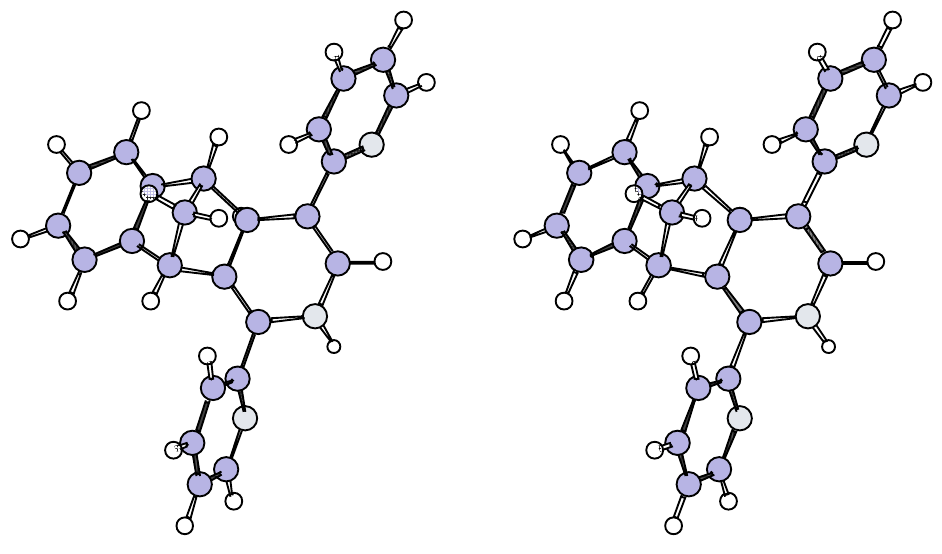
Figure 2. Stereoview of preferred conformation of 29 determined by the AM1 method.